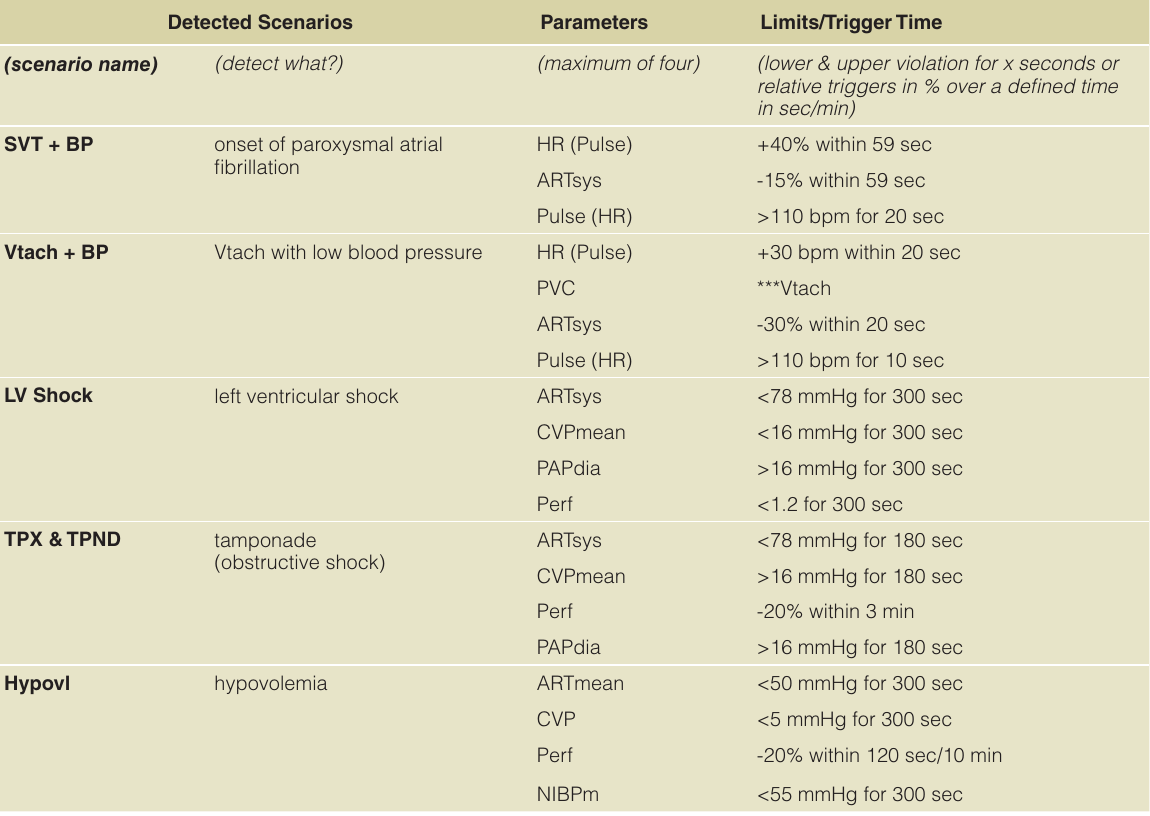
Table 1. Clinical alarm scenarios that were programmed into the bedside